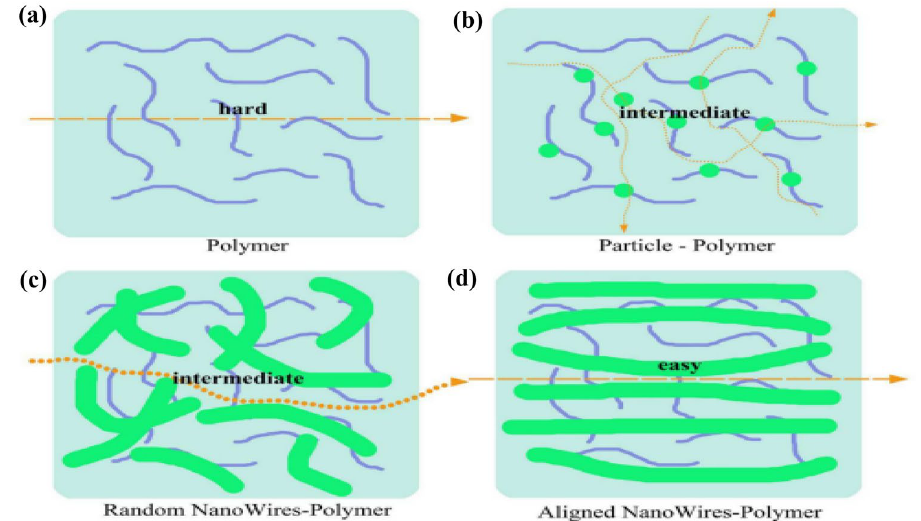
Fig. 6 Illustration of ionic transport pathway in ( a ) pure PEs, b composite PEs with nanoparticles, c random nanowires, and ( d ) aligned nanowires [58]